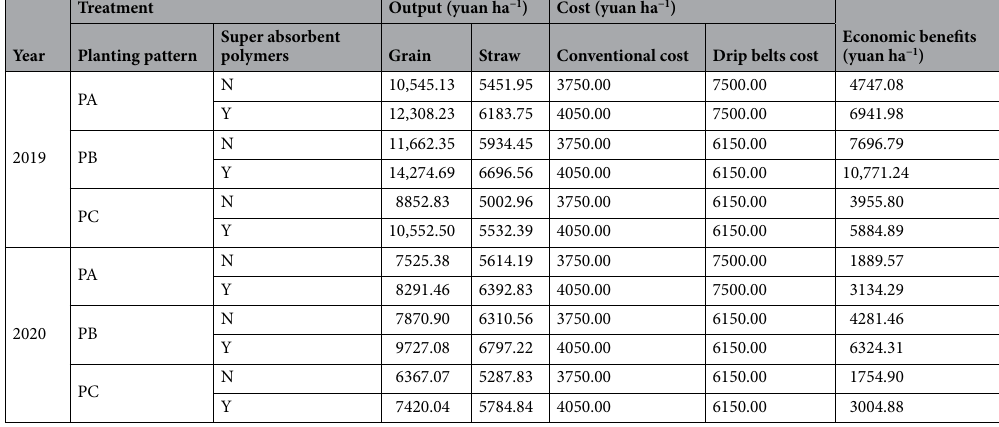
Table 8. Economic benefits as affected by planting patterns and super absorbent polymers in